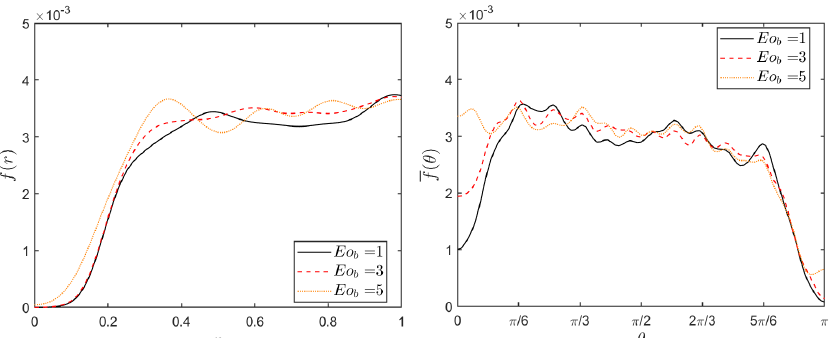
Figure 12. The radial distribution ( left ) and the polar distribution ( right ), averaged around the bubble, for three Eötvös